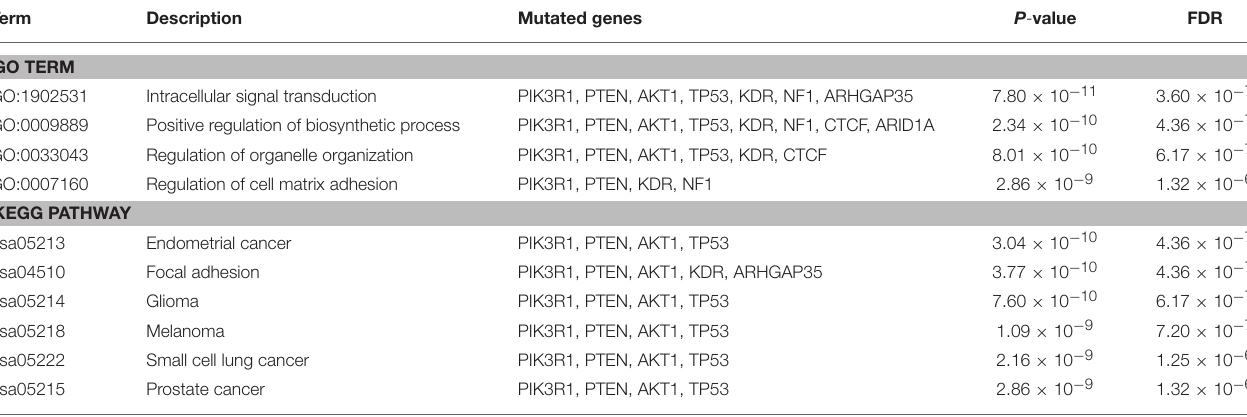
TABLE 3 | Top 10 significantly mutated GO terms and KEGG pathways.